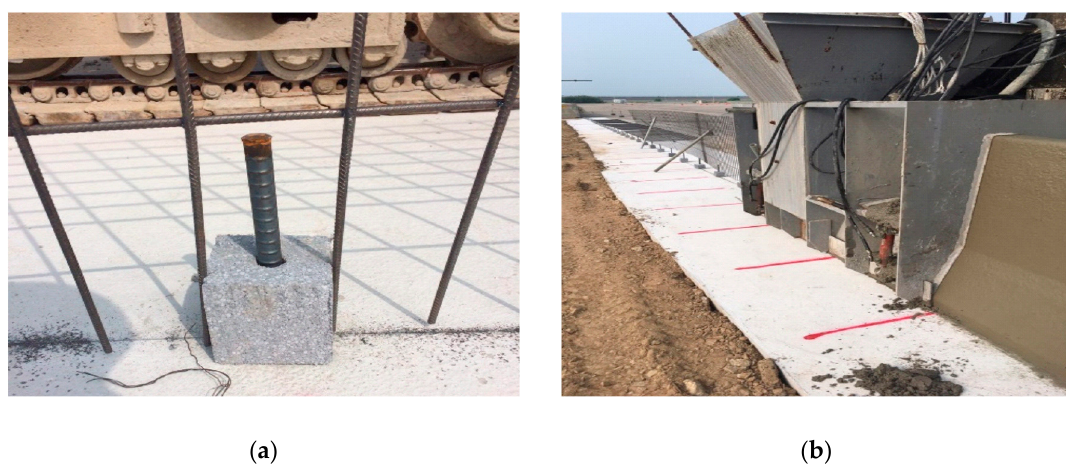
Figure 11. Installation of proposed CMB-17S. ( a ) Shock absorbing device (Dowel bar) for intended deformation; ( b ) Slip-forming concrete median barrier.